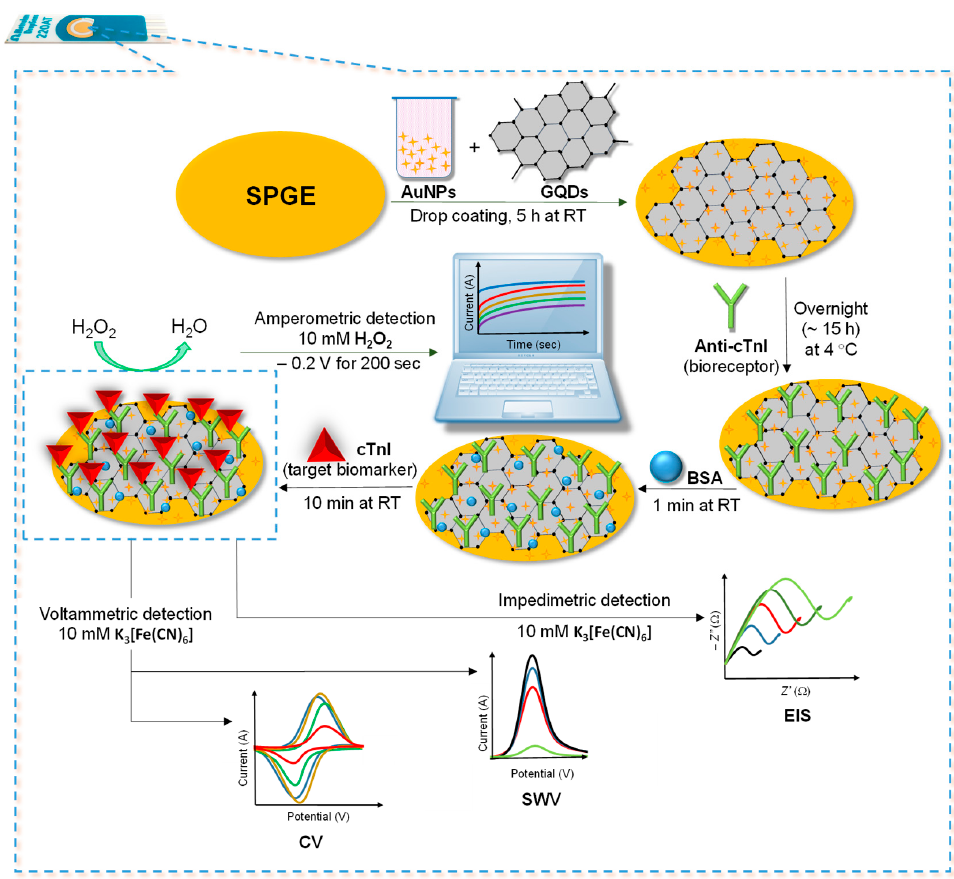
Figure 1. Steps involved for the fabrication of as-designed AuNPs@GQDs-modified screen-printed gold electrode (SPGE)-based label-free electrochemical immunosensor for cTnI detection.